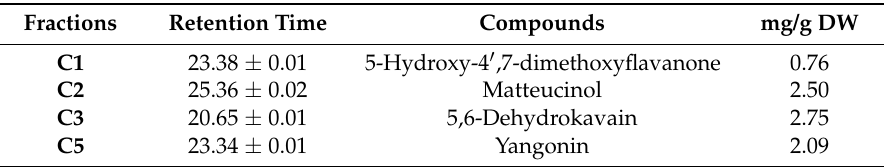
Table 5. Quantity of purified compounds from P. methysticum root.